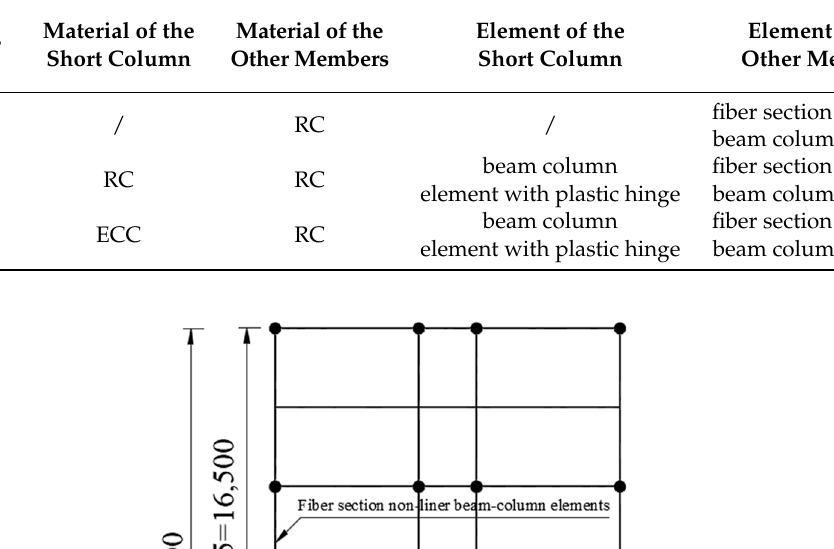
Table 1. Basic information on the analytical frames.